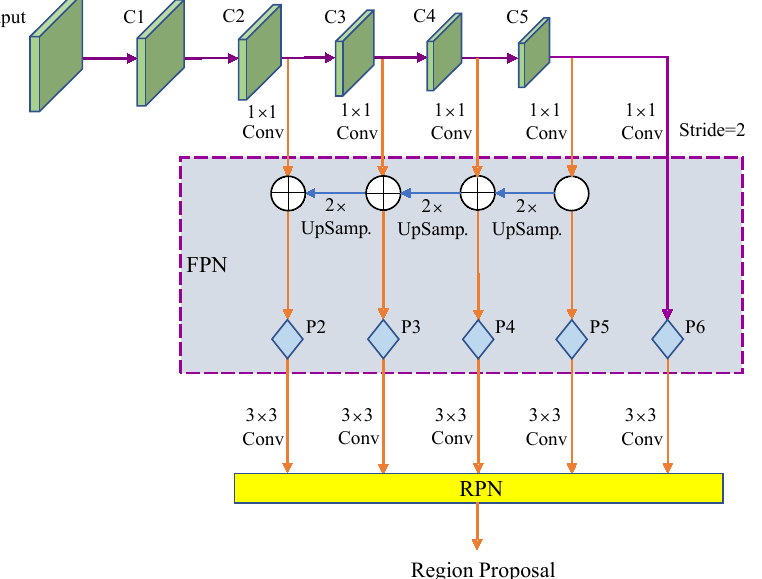
Figure 3. Structure of the backbone network.